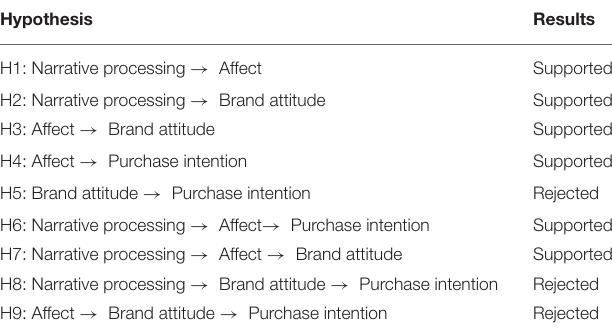
TABLE 4 | Summary of results of hypothesis